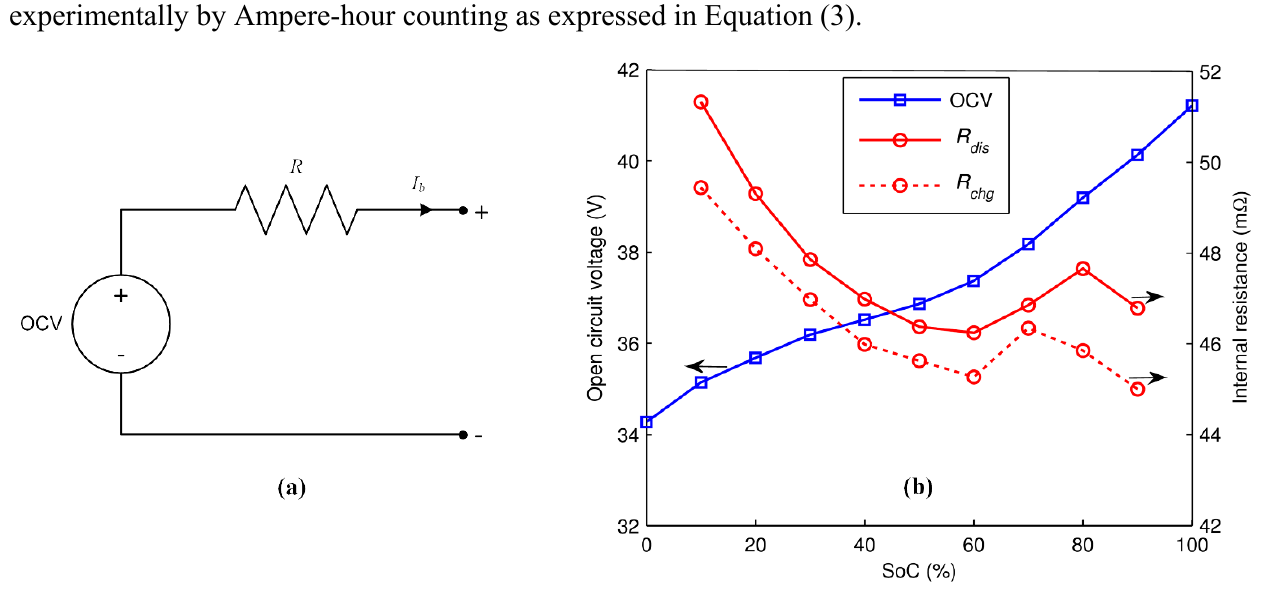
Figure 5. Modeling of the battery by the internal-resistance model. ( a ) Model equivalent circuit; ( b ) Model parameters as a function of